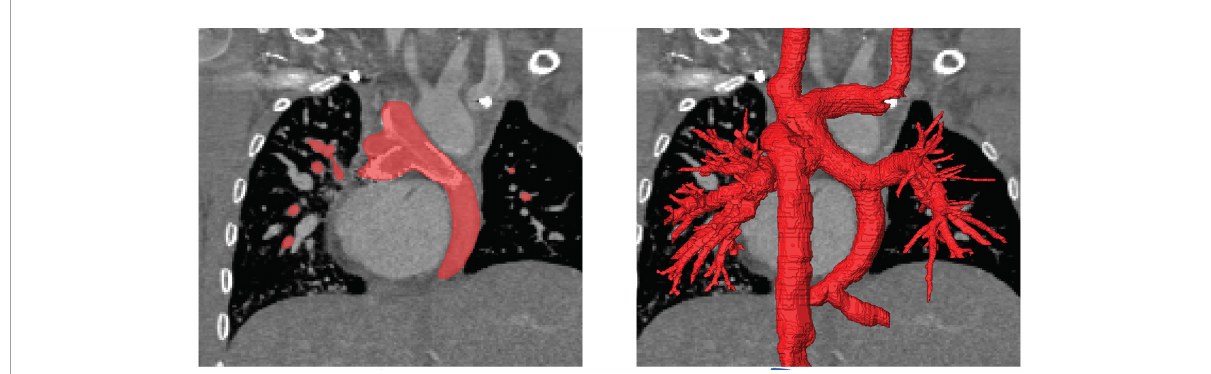
FIGURE1 Illustration of the image-reconstruction procedure. Image voxels belonging to the region of interest were selected either manually or using semi-automatic approaches as for example region growing algorithms based on image intensity as well as local intensity gradients (left) . This procedure was performed for all slices and all three reconstruction orientations, to obtain the three-dimensional label mask of the patient-specific anatomy (right)